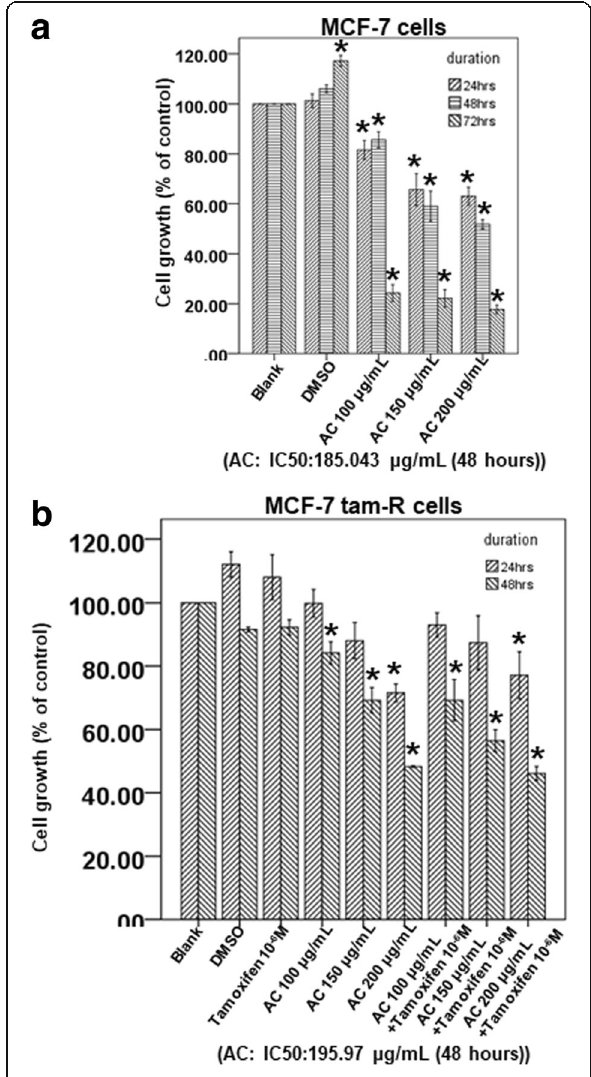
Fig. 2 AC block the proliferation of breast cancer cell lines. MCF-7 cells (a) or tamoxifen resistant MCF-7 cells (MCF-7 tam-R cells) (b) were measured by XTT assay after indicated hours of culturing in the presence of indicated compounds. All the results are representative of at least three independent experiments. (Error bars =mean±S.E.M. Asterisks (*) mark samples significantly different from blank group with p